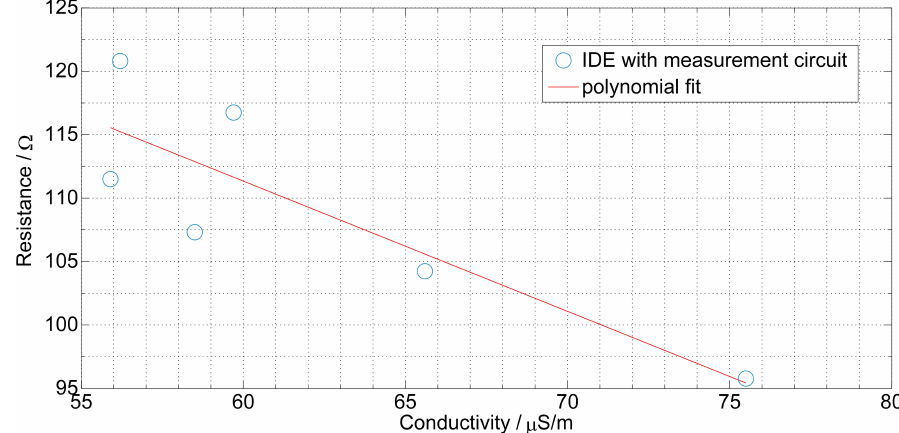
Figure 15. Correlation of the measured capacitance with the relative permittivity of sunflower oil measured in the reference measurement. The measurements are carried out by the measurement circuit and the IDE (inter-digital electrodes) sensor.